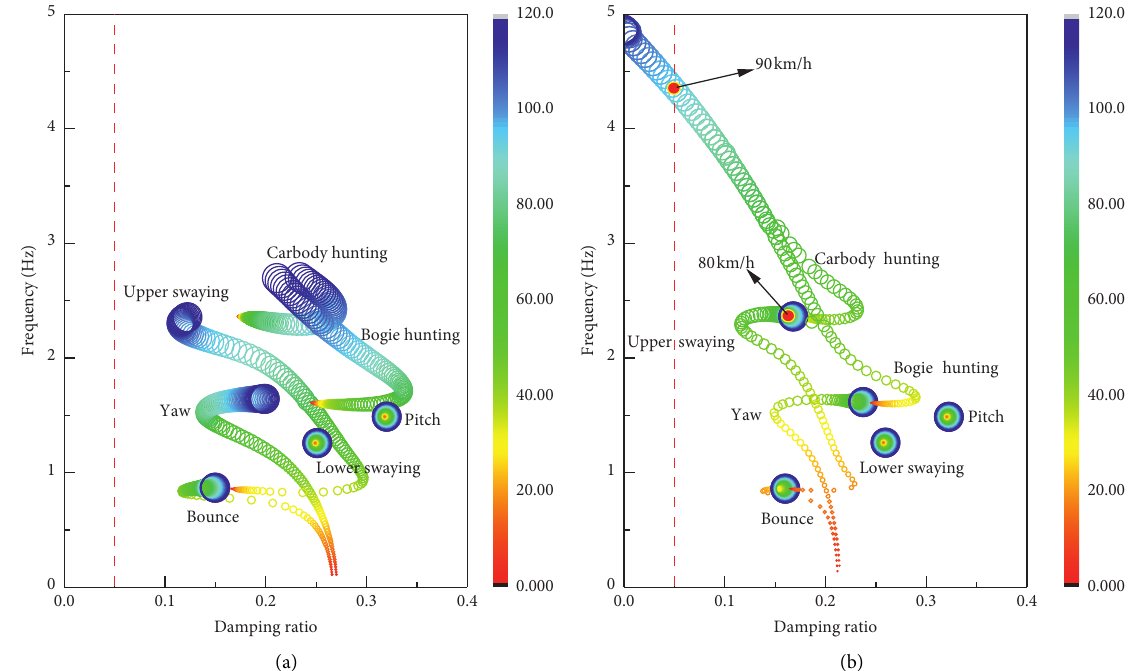
Figure 19: Root-locus diagrams of vehicle dynamic model simulation. (a) Equivalent conicity is 0.1. (b) Equivalent conicity is